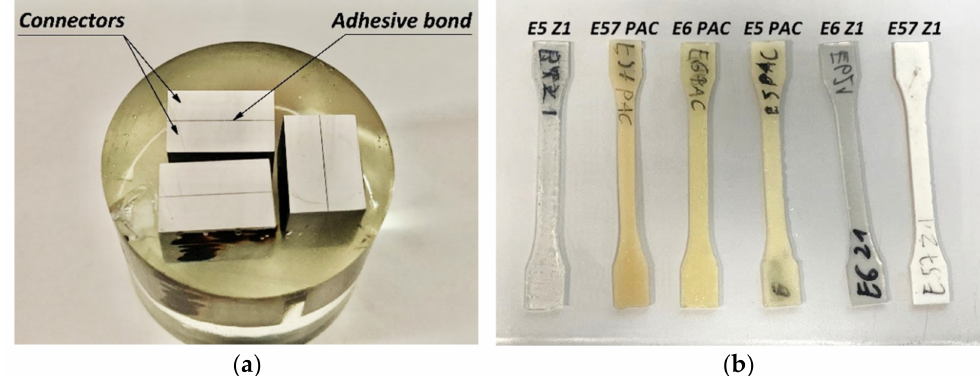
Figure 2. Samples of the adhesive bonds prepared for nanoindentation testing ( a ), dumbbell-shaped samples for tensile testing ( b